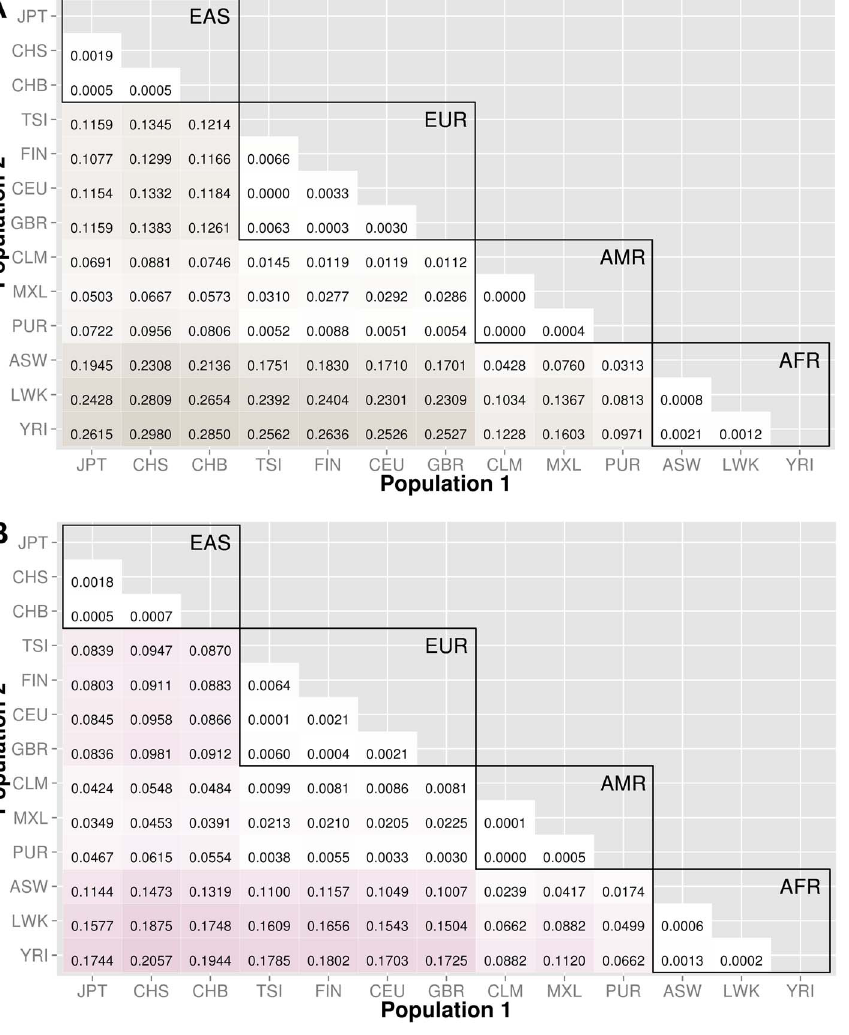
Figure 4. Proportion of significantly different bins for gene-exon filters: A) nonsynonymous and B) predicted deleterious variants. The abbreviations for the each population on are on the x and y-axes. The numbers in each block and the color intensity [0,1] indicate the proportion of significant bins (after Bonferroni correction) for the 1000 Genomes populations on each axis, where the darker the color, the higher the proportion of significant bins. In general, the x-axis is organized with African descent populations on the far right and increasing differentiation with regard to low frequency burden towards the left (i.e. populations of Asian descent have the highest proportion of significant bins compared to African descent groups). Filtering gene exon regions by mutation type and predicted functional significance lead to smaller bins and overall greatly reduced proportions of significance.